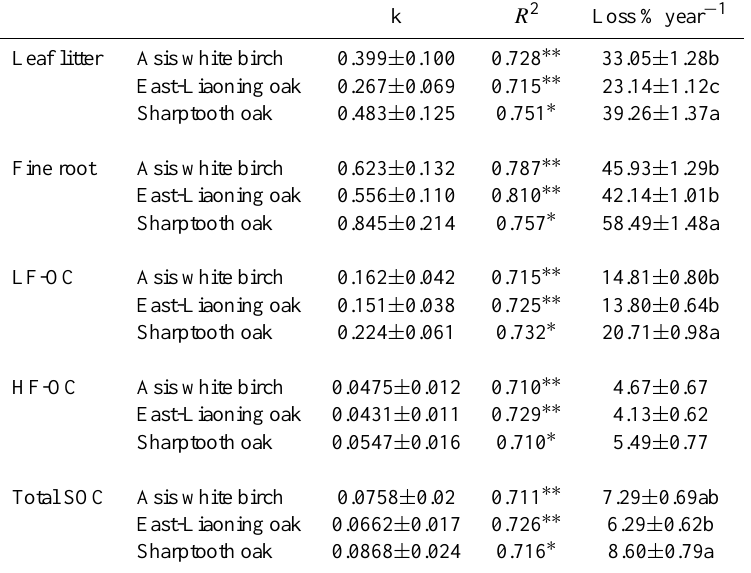
Table 3. Mean annual decay/mineralization constants (k) of leaf litter and fine root, and light fraction organic carbon (LF-OC), heavy fraction organic carbon (HF-OC) and total soil organic carbon (SOC) in Asia white birch and East-Liaoning oak forests of warm temperate zone and Sharptooth oak forest of sub-topical zone. Values represent mean ± standard error derived from eight-time sampling with five replicates for Asia white birch and East-Liaoning oak forests, and seven-time sampling with five replicates for Sharptooth oak forest. Mass loss per year was estimated as: 100 × (initial mass – final mass)/initial mass. Different letters in each column are significantly different ( P < 0.05) according to the least significant difference test. R 2 , multiple coefficient of determination and significance level of the exponential model ( ∗ P < 0.05; ∗∗ P < 0.01) are also given.